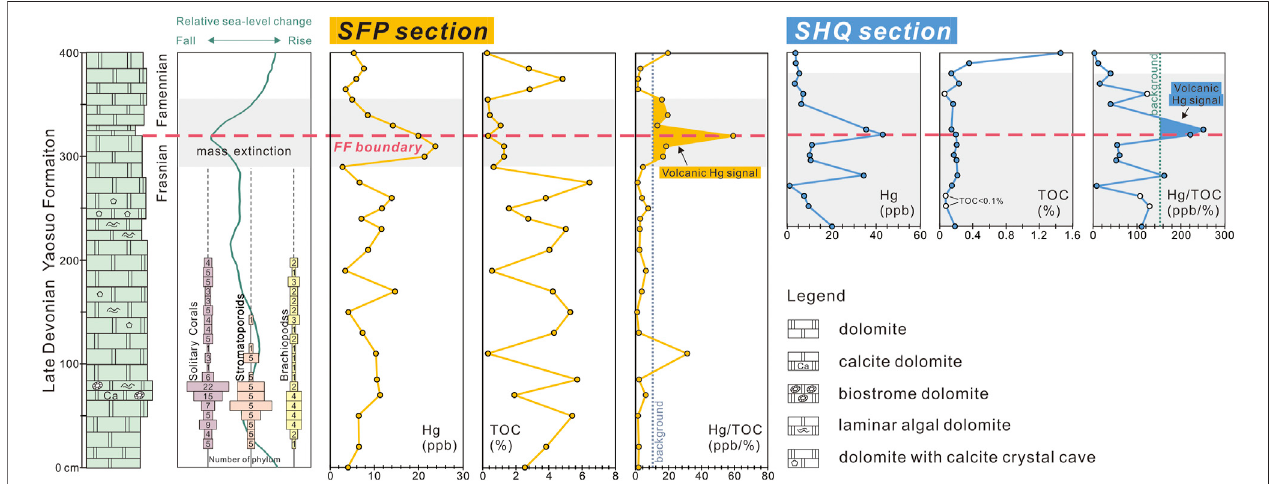
FIGURE4| Diagramshowingstratigraphyandlithology,changesintheabundanceofbodyfossils(massextinctionlevelsaremarkedingray)andsealevel,Hgand TOC concentrations, and Hg/TOC variation patterns across the F – F transition of two sections in the Dushan area, South China. White cycles indicate the samples with low TOC values ( ≤ 0.1%).